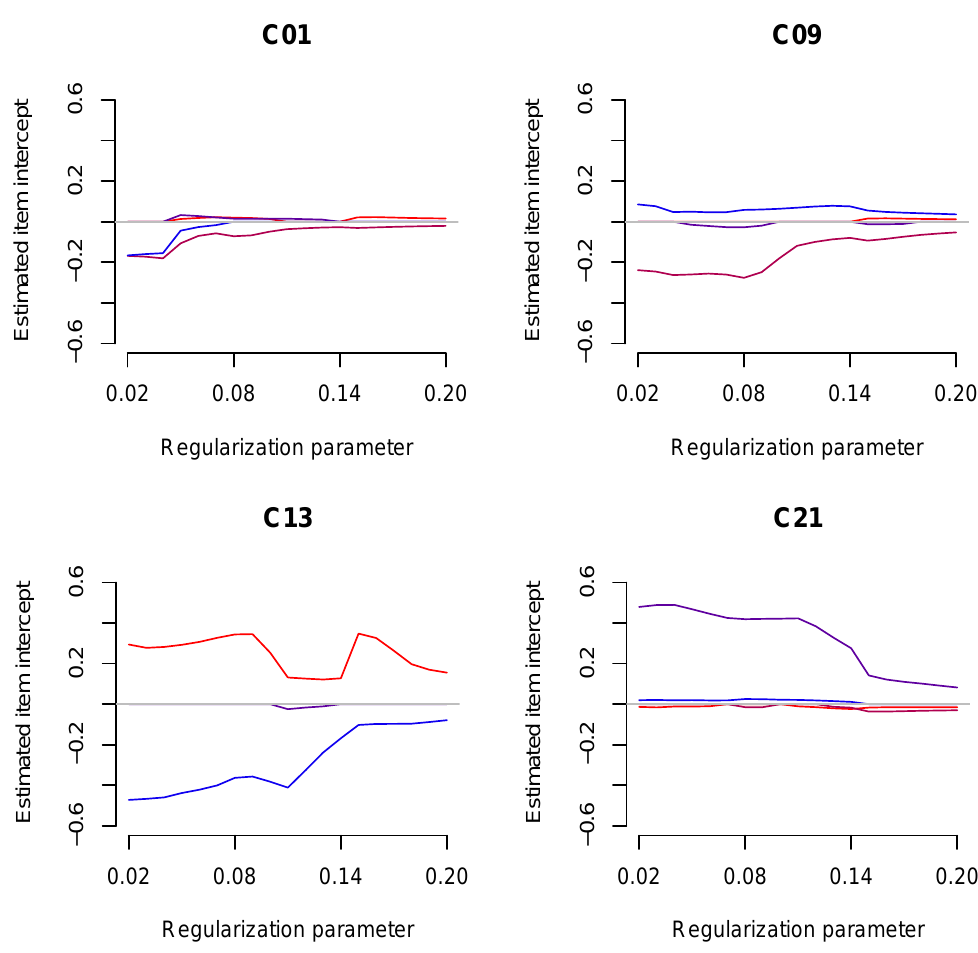
Figure 4. Empirical example: Regularization paths for estimated country-specific item intercepts in regularized maximum likelihood estimation as a function of the regularization parameter κ ν